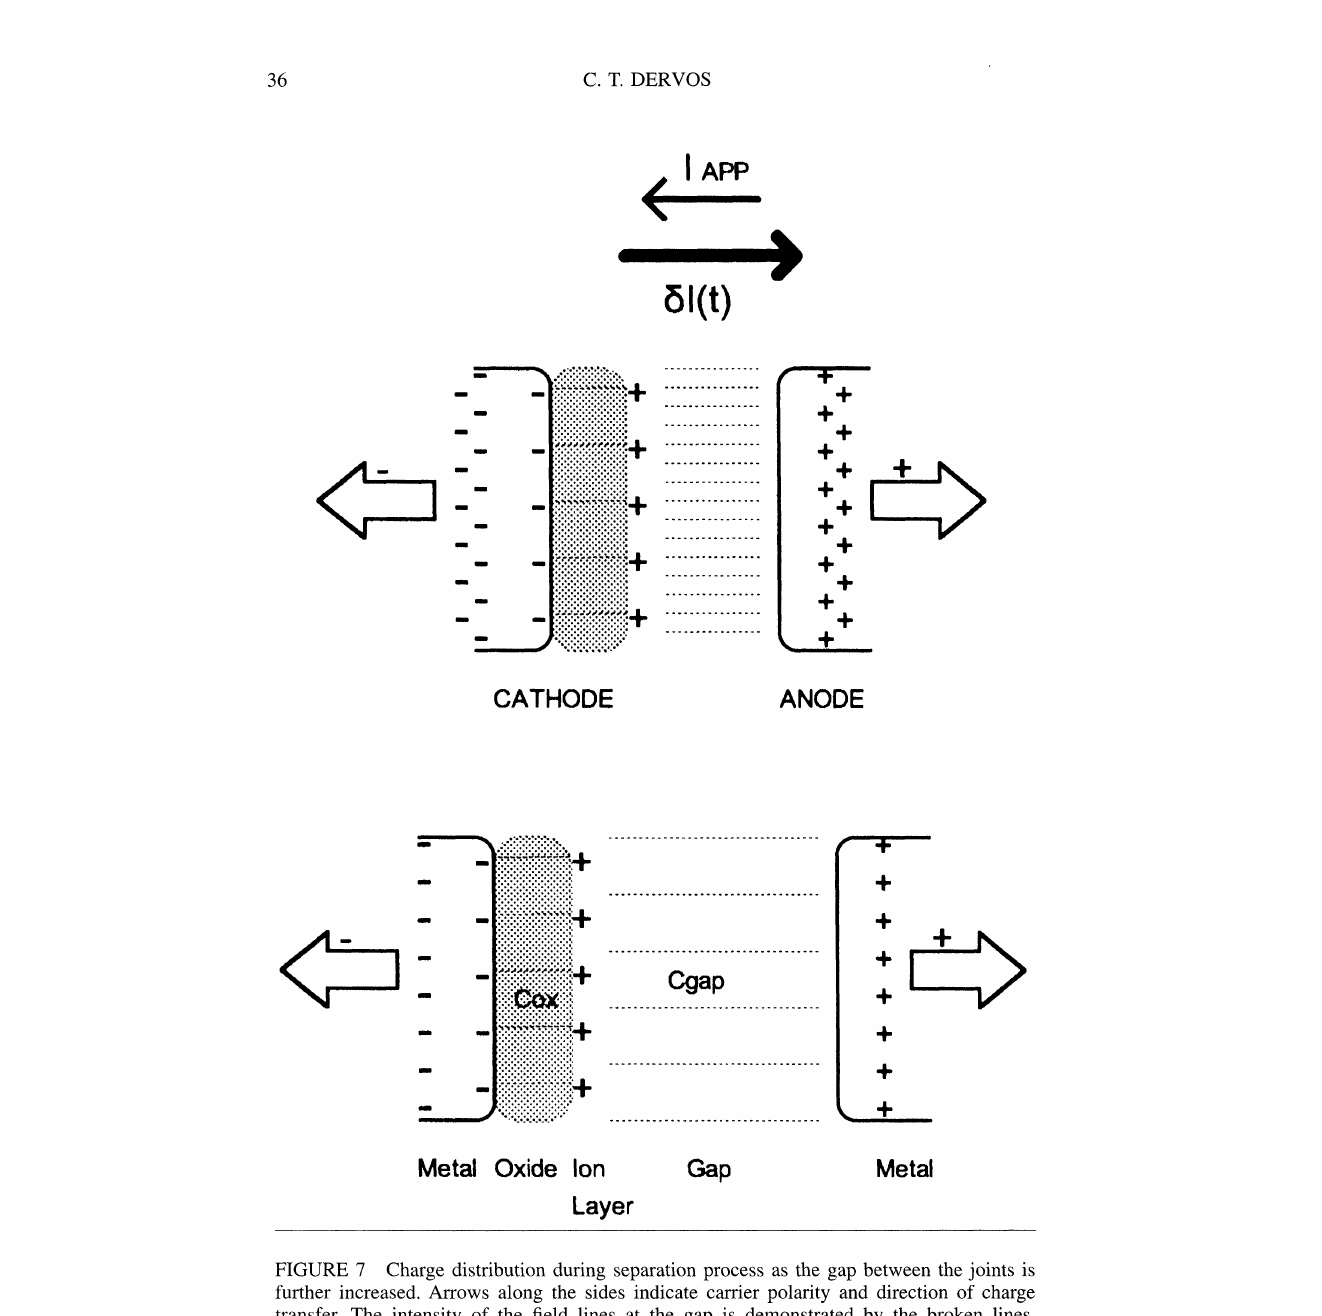
FIGURE 7 Charge distribution during separation process as the gap between the joints is further increased. Arrows along the sides indicate carrier polarity and direction of charge transfer. The intensity of the field lines at the gap is demonstrated by the broken lines. Conventional current flow directions for Iap P and gI(t) are indicated at the